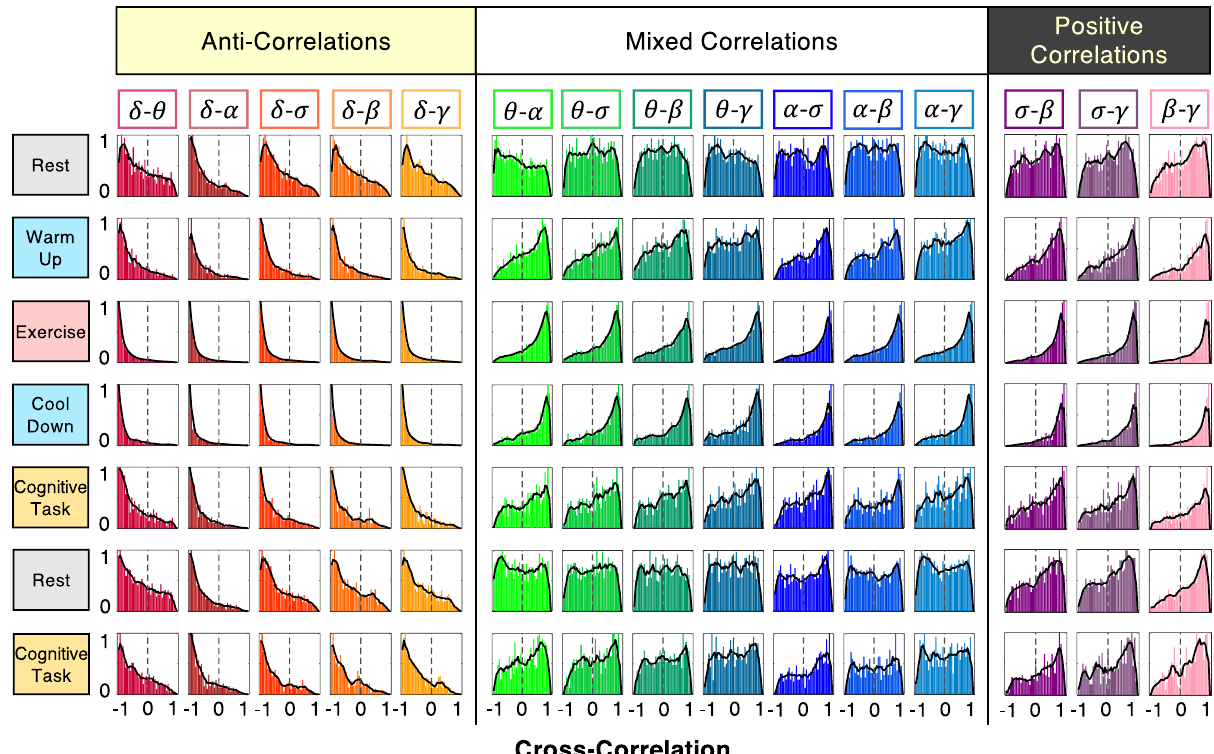
Fig. 2 Transitions in brain-rhythm interactions across physiologic states. Cross-correlation distribution pro fi les for each pair of brain rhythms during different physiologic states (pooled data from all subjects in the database from two separate tests repeating the same protocol on different days at high (80% VAT) and low (20% VAT) level of physical effort during exercise; see also Supplementary Fig. 2). Distributions are rescaled by the peak values of cross-correlation and smoothed by moving average (solid lines, see Methods). For all states, interactions among distinct brain rhythms fall in three major classes: (i) anti-correlated coupling with predominantly negative correlation values for the pairs δ - θ , δ - α , δ - σ , δ - β , δ - γ ; (ii) positively correlated coupling with predominantly positive correlation values for the pairs α - σ , α - β , α - γ , σ - β , σ - γ , β - γ ; and (iii) mixed-correlated coupling for θ - α , θ - σ , θ - β , θ - γ , where the coupling pro fi le gradually changes (along each column) from weakly negative to homogeneous and positive. Note that within these major classes, the coupling pro fi le for each pair of cortical rhythms exhibits consistent modulation with transitions across states, e.g., fast-decaying tail during exercise (strong coupling), slow-decaying tail during the cognitive task (intermediate coupling), and fat tail during rest (weaker coupling). A unique ensemble of coupling pro fi les (along each row) characterizes each physiological state, and transitions across states are associated with changes in correlation pro fi les re fl ecting reorganization of brain-rhythm interactions. These fi ndings indicate that a speci fi c set of brain-rhythm coupling forms (an ‘ alphabet ’ of pro fi les) uniquely de fi nes each physiologic state, and that a complex hierarchical organization in the cross-communication among brain rhythms is a hallmark of physiologic states and